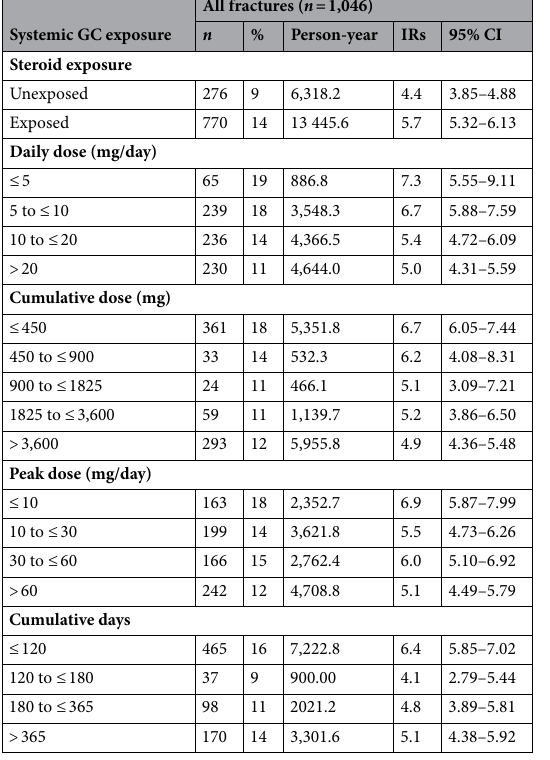
Table 3. Crude fractures incidence rates (IRs) per 100 person-years by glucocorticoid level of exposure among all study populations (unexposed, n = 3,153; exposed, n = 5,471). GC glucocorticoid, CI confidence